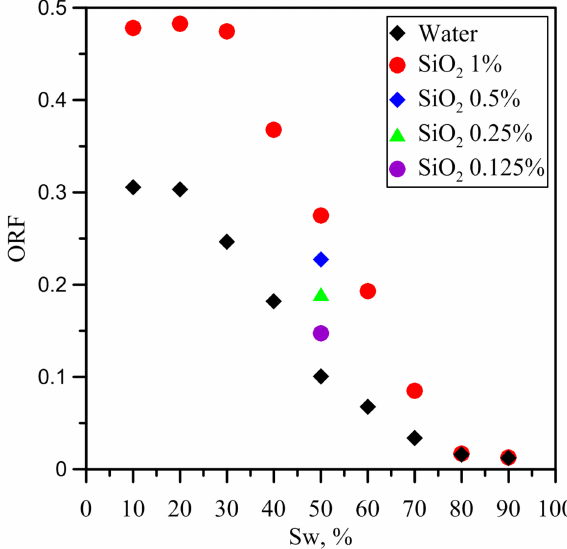
Figure 7. Dependence of the ORF on the water saturation of a porous medium using water and SiO 2 nanosuspension.